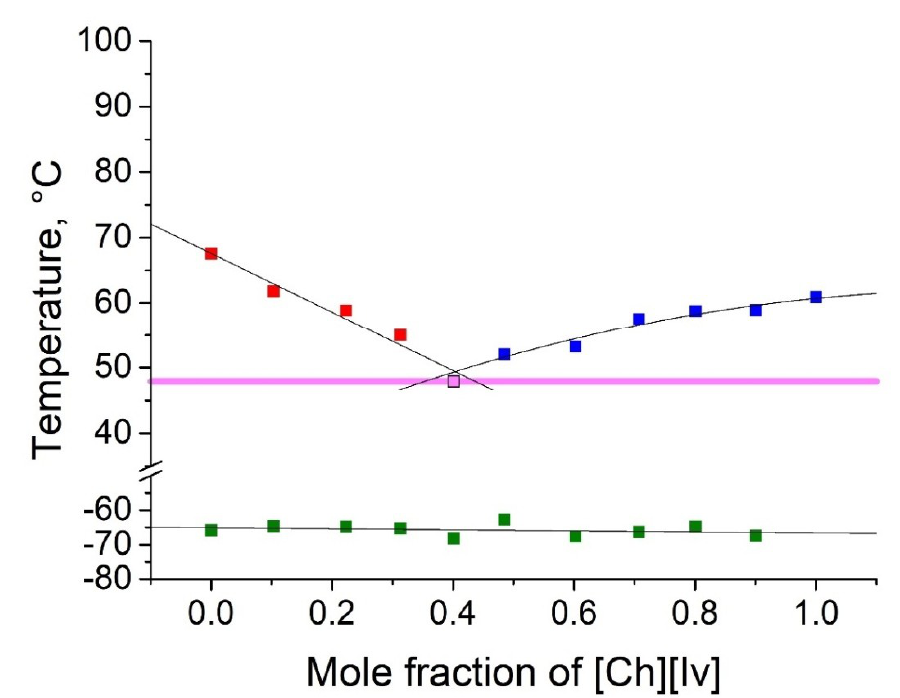
Molecules 2020 , 25 , x FOR PEER REVIEW Figure 4. Temperature-composition phase diagram for the mixture of [Ch][Ib] and [Ch][2mb], and their individual components at 0.0 and 1.0 mole fractions. Legend: ▪—melting point of the excess component [Ch][Ib] in the mixture; ▪—melting point of the excess component [Ch][2mb] in the mixture; ▪—glass transition temperature; ▪—eutectic point; – eutectic transition line.